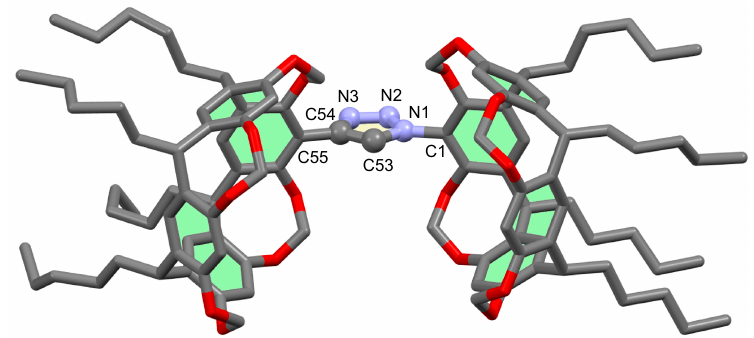
Figure 2. X-ray structure of triazole 8 . Only one of the two molecules present in the unit cell (molecule A) is shown. Selected bond lengths (Å): C1-N1 1.462(6); N1-N2 1.320(6); N2-N3 1.335(7);